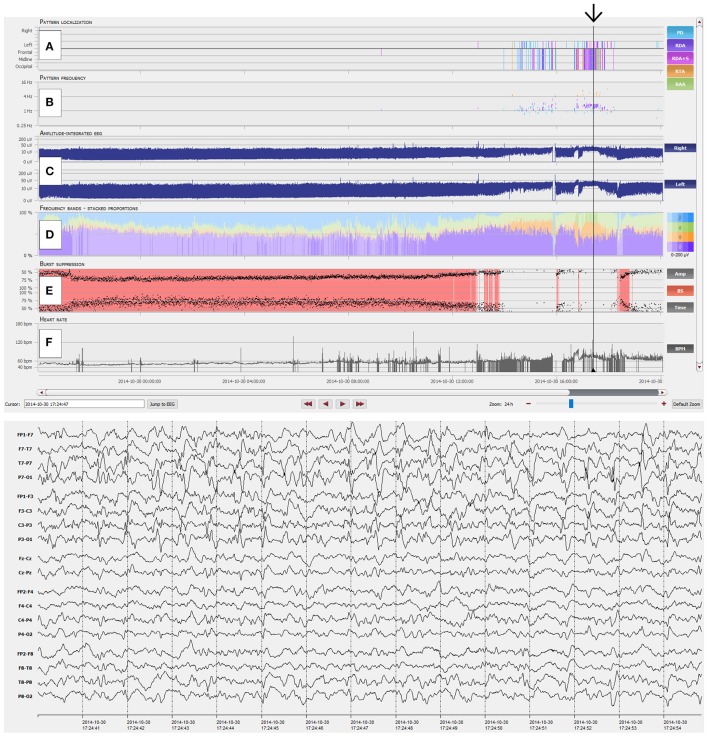
Overview of the NeuroTrend graphical user interface (GUI). (A) Automatic, color coded pattern detection (light blue: PD, periodic discharges; violet: RDA, rhythmic delta activity; pink: RDA+S, rhythmic delta activity plus superimposed spikes; orange: RTA, rhythmic theta activity; light green: RAA, rhythmic alpha activity); (B) Related frequencies of detected EEG patterns (the same color code as in A is used); (C) Amplitude integrated EEG for left and right hemisphere; (D) Frequency bands (beta-alpha-theta-delta) in a color coded (blue: beta; green: alpha; orange: theta; violet: delta), stacked proportion view (stronger colors signal higher amplitudes); (E) Burst suppression detection (continuous red markers signal presence of burst suppression); (F) Heart rate frequency plot. The black arrow highlights an EEG example of 1.5-2 c/s left hemispheric periodic discharges with superimposed rhythmic activity, which can be easily detected with the Neurotrend GUI.